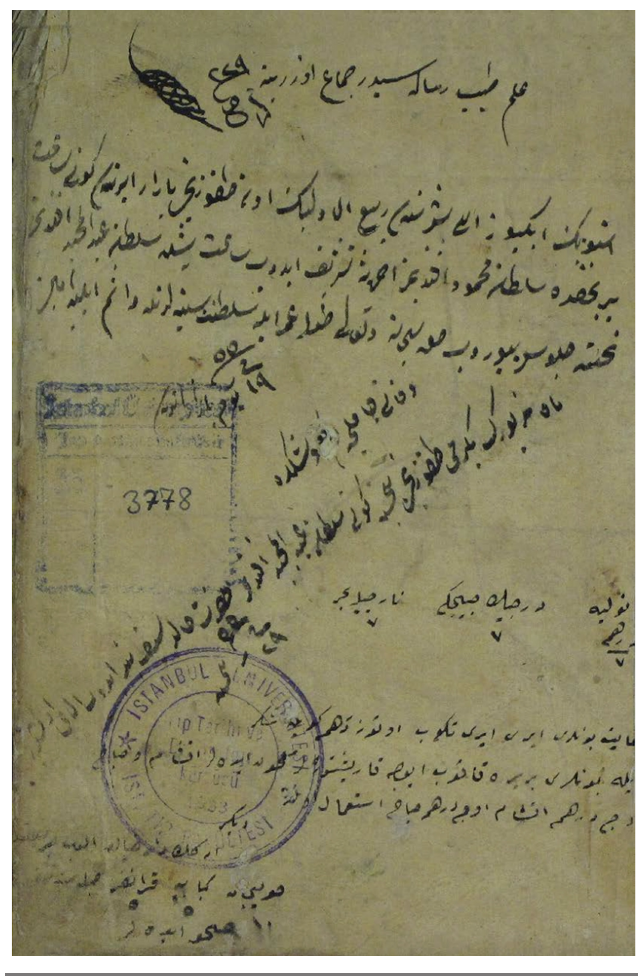
Figure 1. Cover image of the copy registered at the Library of number